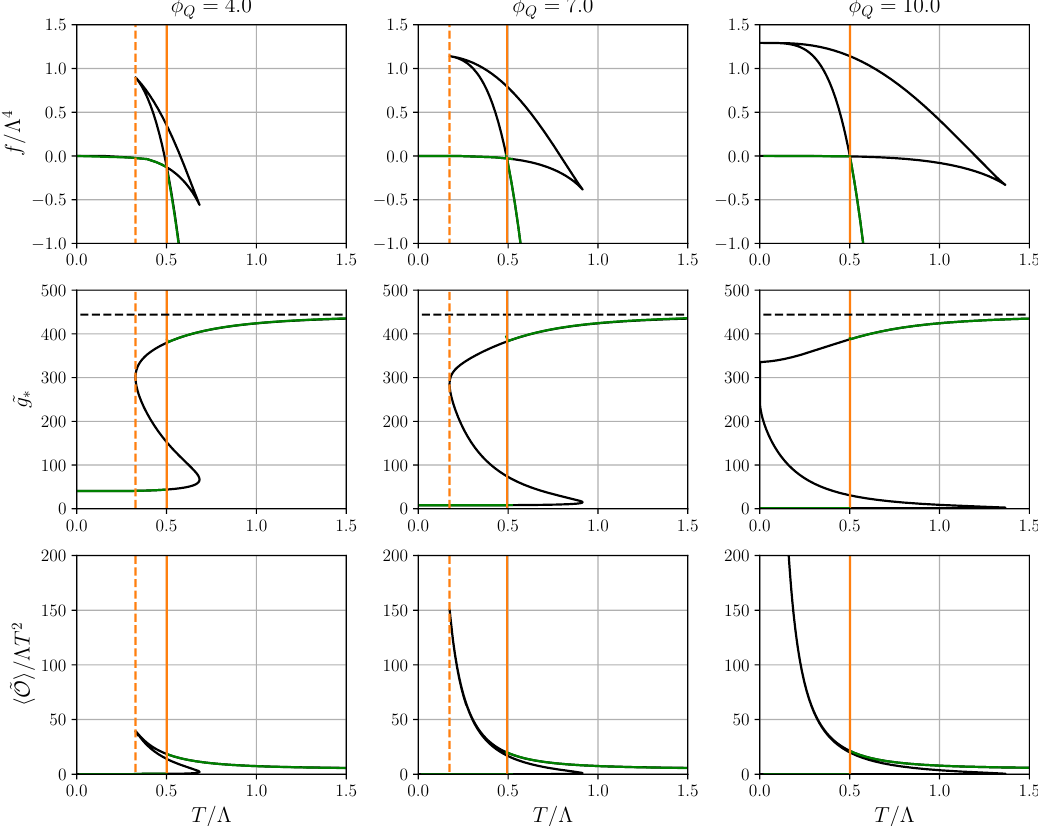
Figure 3 . Free energy density f , rescaled degrees of freedom ˜ g ∗ , and dimensionless scalar conden- sate h ˜ Oi over temperature for varying φ Q at constant φ M ≈ 0 . 58 . The solid yellow line on each plot shows the critical temperature T c , the dashed yellow line on each plot shows the last temperature at which the metastable phase exists T 1 , the green line shows the stable phase, and the black dashed line on the middle row plots shows the asymptotic value of ˜ g ∗